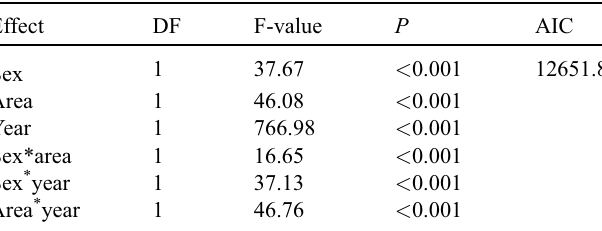
Table A.1. Predicted share of the 5 – 12-year-old mature white fi sh in the northern and southern Gulf of Bothnia in relation to the catch year and sex.